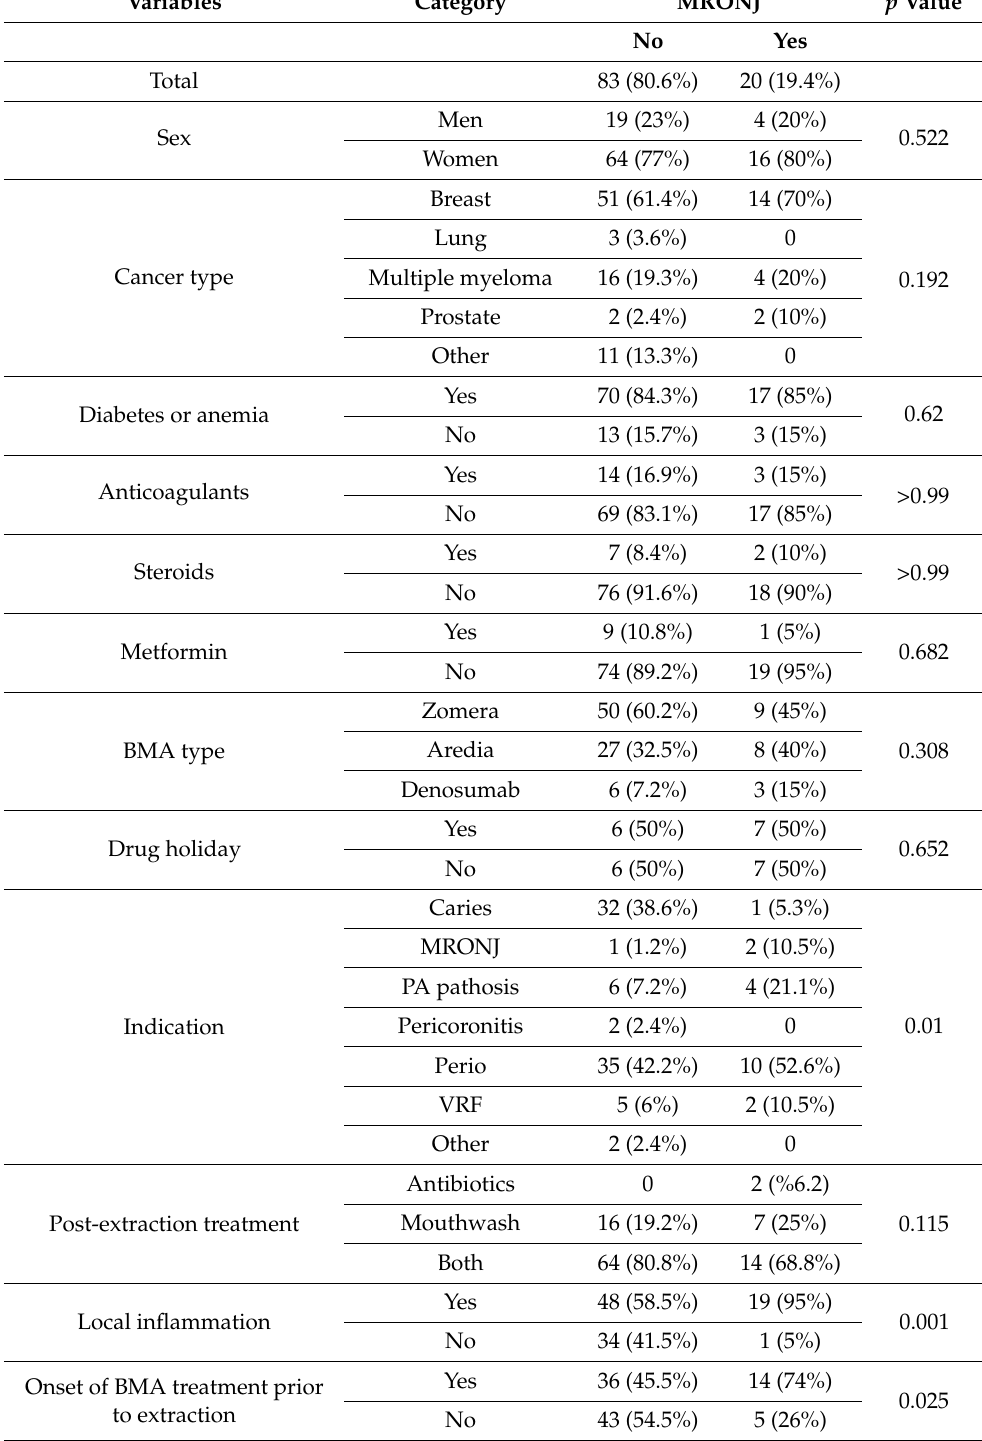
Table 3. Relationship between categorical variables for the development of MRONJ in 103 extraction